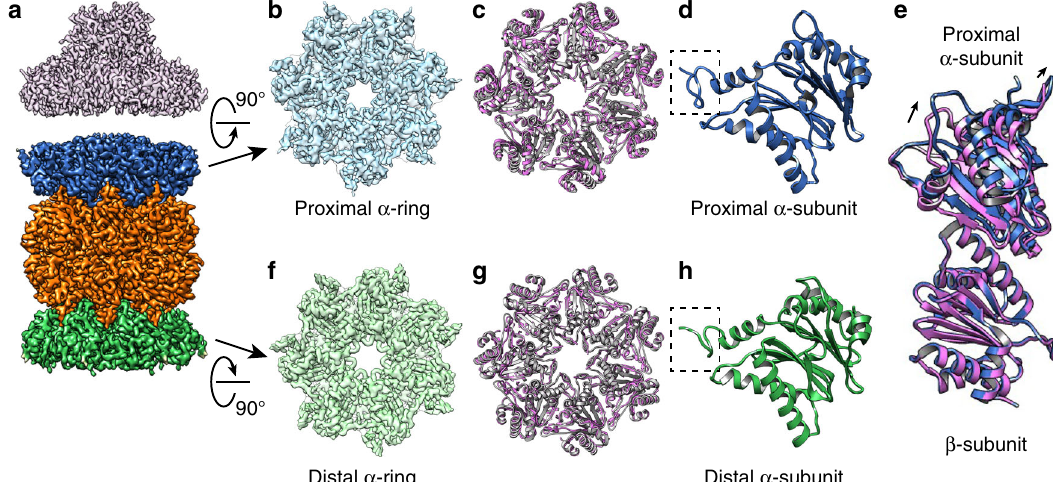
Fig. 4 Single-particle cryo-EM structure of PAN- α WT ββα K66A complex with GFP-ssrA substrate. a Cryo-EM reconstruction of PAN- α WT ββα K66A with substrate GFP-ssrA at a resolution of 3.4 Å. b Proximal α -ring of the 20S CP. c Ribbon diagram of proximal α -ring (gray) overlayed with that of the α -ring in closed conformation without bound activator (purple). Note that the two do not overlap. d Ribbon diagram of α -subunits from proximal α -rings. The N- terminus of α -subunit within the dashed box points upwards in an open gate conformation. e Ribbon diagram of an α -subunit from the proximal α -ring and its interacting β -subunit (gray) overlayed with the ribbon diagram of α / β -subunits from a 20S CP without activator bound (purple). Note that the β -subunit is perfectly aligned between the two, and α -subunit is rotated. f Distal α -ring of the 20S CP. g Ribbon diagram of distal α -ring (gray) overlayed with that of the α -ring in closed conformation without bound activator (purple). Note that the two overlap nicely. h Ribbon diagram of α -subunits from distal α -rings. The N-terminus of a-subunit within the dashed box points upwards in an open gate